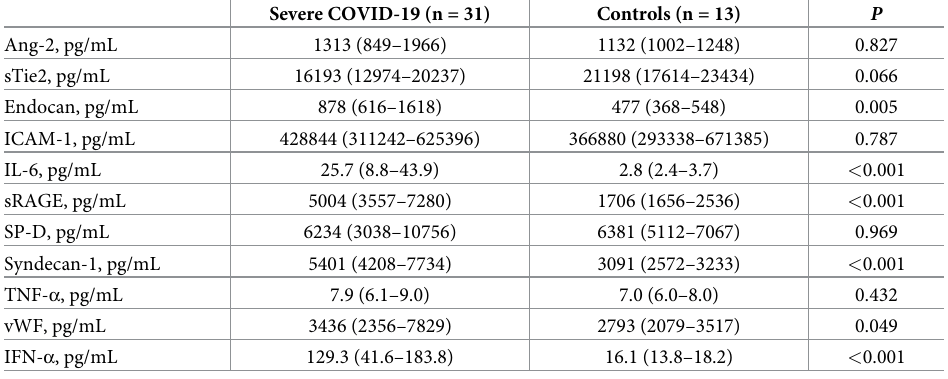
Table 2. Comparing plasma biomarker concentrations between 31 patients with severe COVID-19 and 13 healthy individuals.